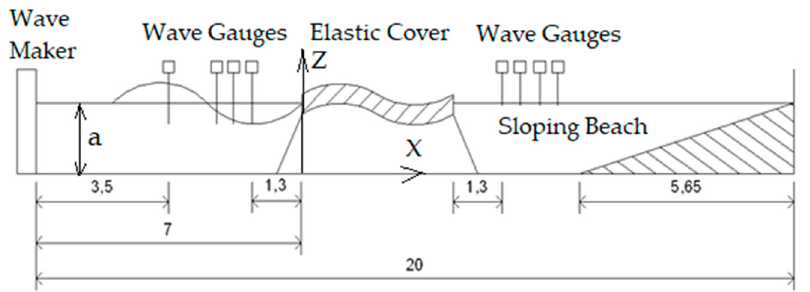
Figure 2. Schematic view of the experimental setup.